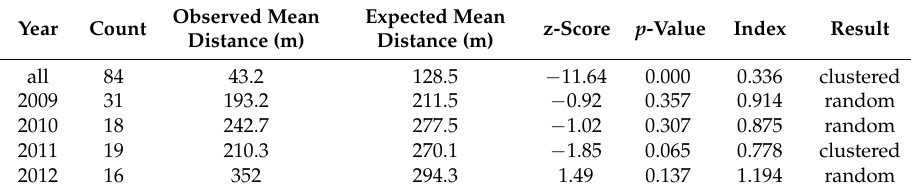
Table 1. Results of the Average Nearest Neighbor Analysis for fox den entrance locations by